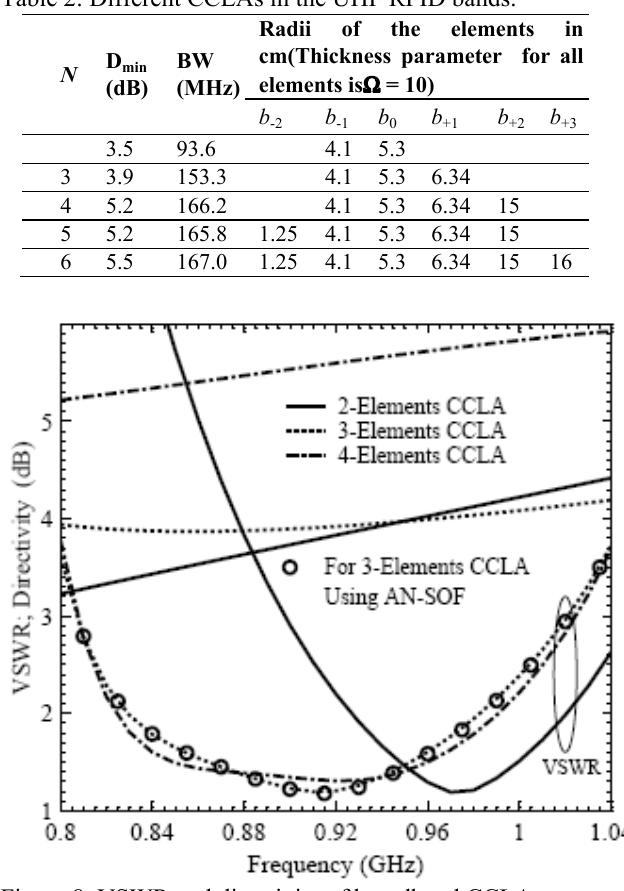
Figure 8: VSWR and directivity of broadband . 0